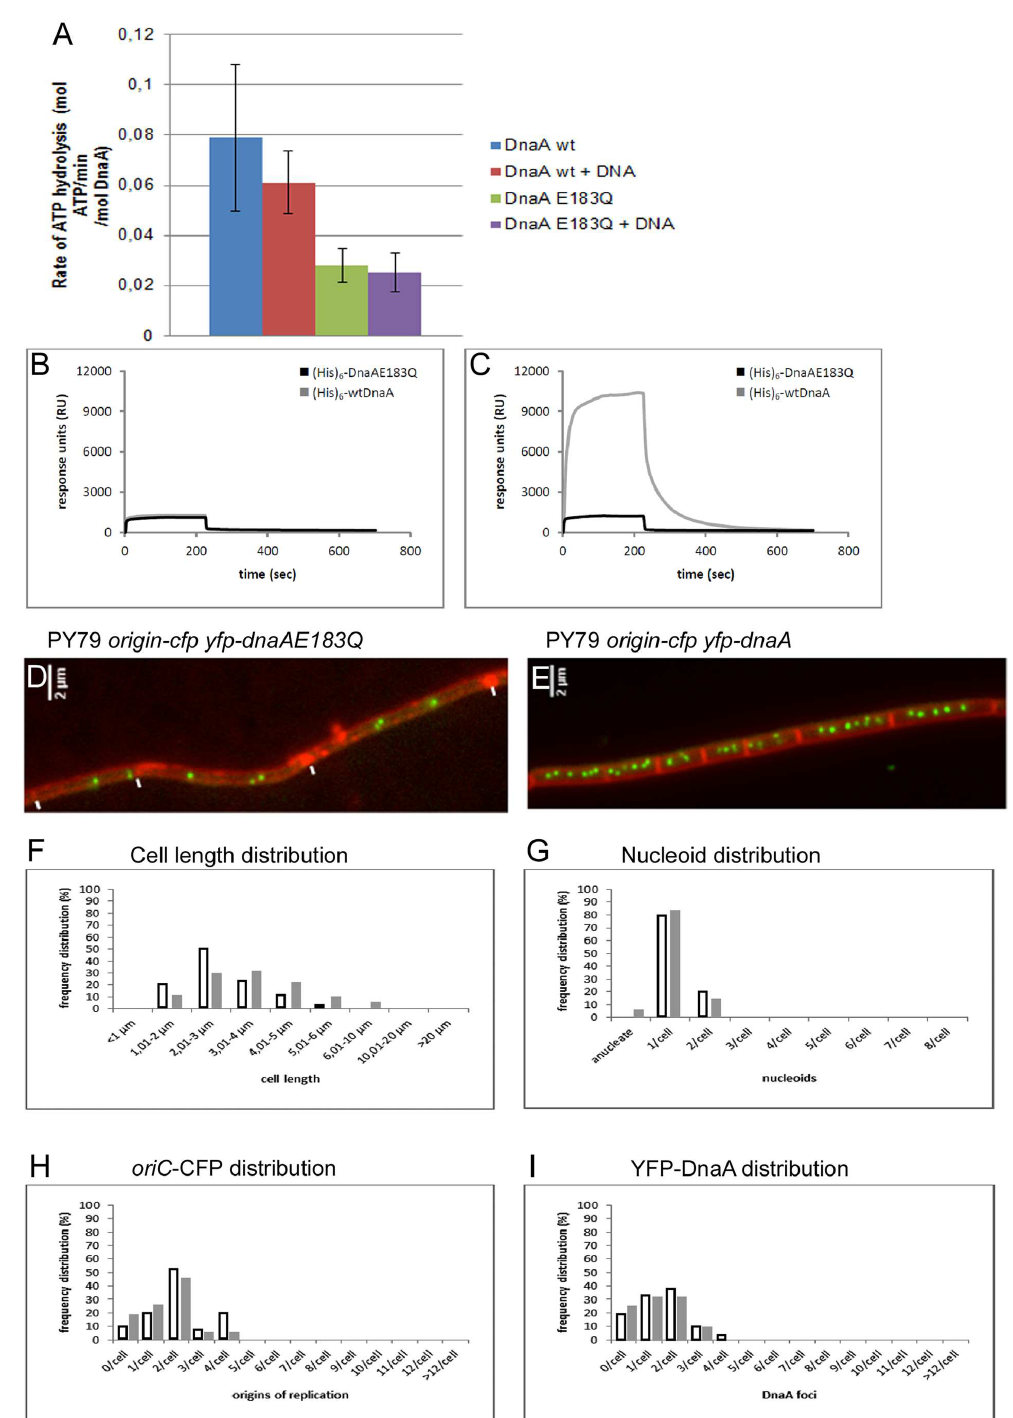
Fig 8. DnaAE183Qmutant shows reduced ATPase activity and an underinitiating phenotype. A) Coupled ATPase assay of purifiedwild type DnaA or of DnaAE183Q (10 μ M). B) Surface plasmonresonance [SPR] experiments with DnaA and DnaAE183Q[2.5 μ M] bindingto oriC -DNA [0.25 pmol]. Black line: DnaAE183Q, grey line: wtDnaA. C) SPR in the presenceof 2.5 mM ATP. D-E) Fluorescence microscopy analysisof cells growing exponentially in rich (LB) medium,D) expressingYFP-DnaAE183Q for 60 minutes, E) expressingYFP-DnaA for 60 minutes. Note that cells contain more oriC regions in rich medium comparedwith minimalmedium as in Figs 1